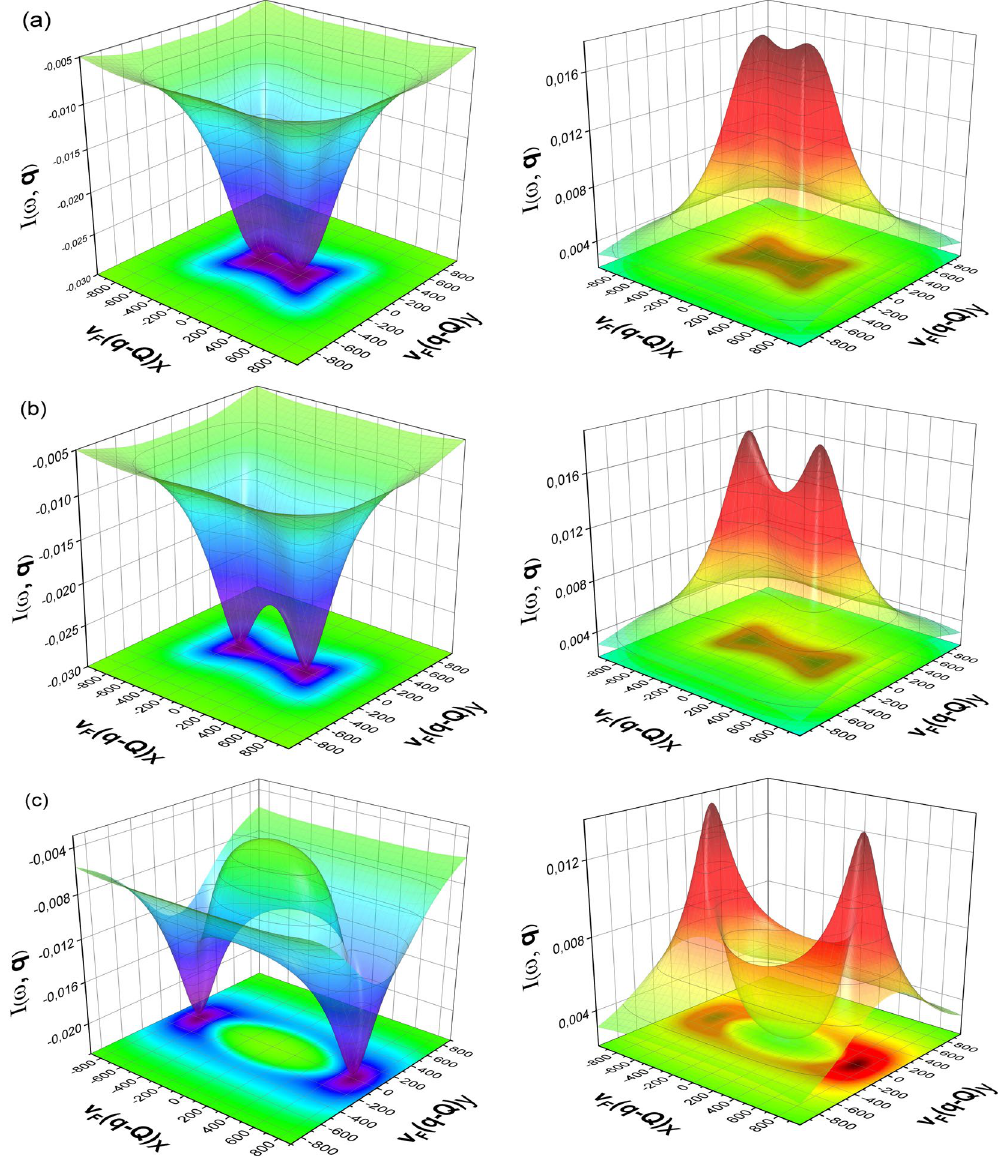
= 18. Here, the panels ( a ),( b ),( c ) b